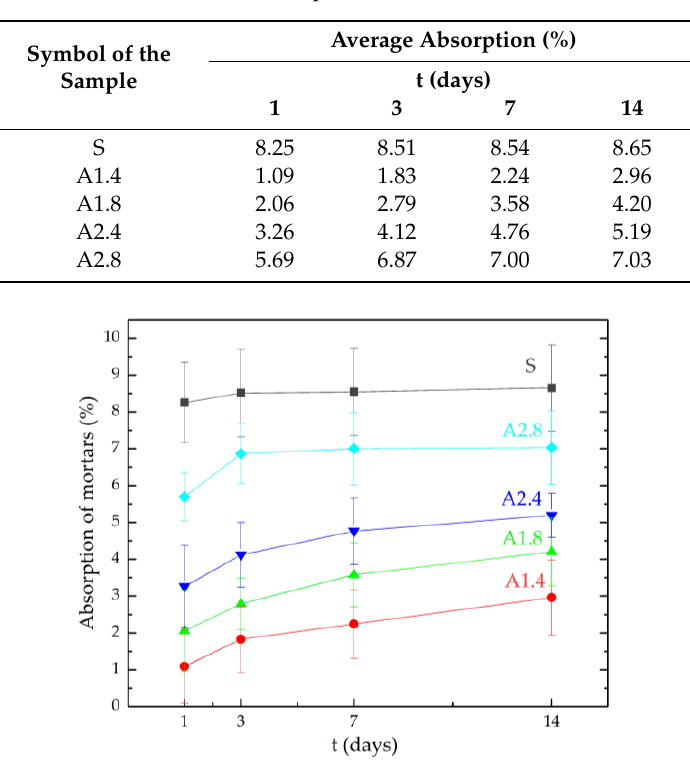
Figure 1. Absorption of mortars after 7, 14 and 28 days.